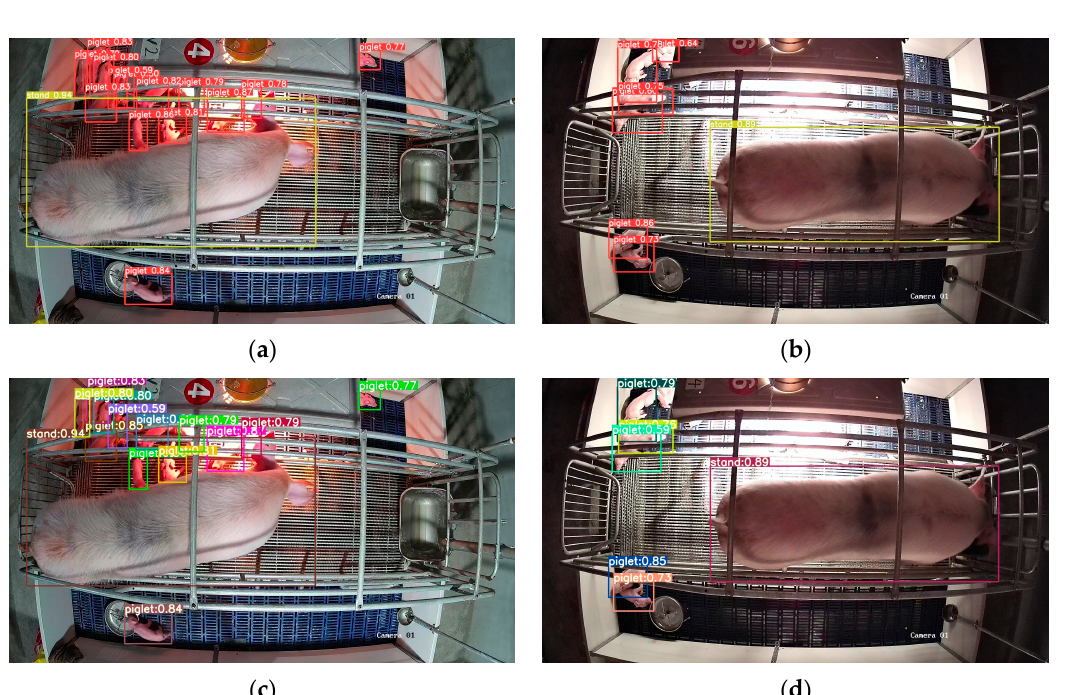
Figure 9. Test results before and after model optimization. ( a ) Test result on Quadro P4000 in daytime, ( b ) Test result on Quadro P4000 at night, ( c ) Test result on Jetson Nano in daytime, ( d ) Test result on Jetson Nano at night . Table 3. Model test effect comparison.